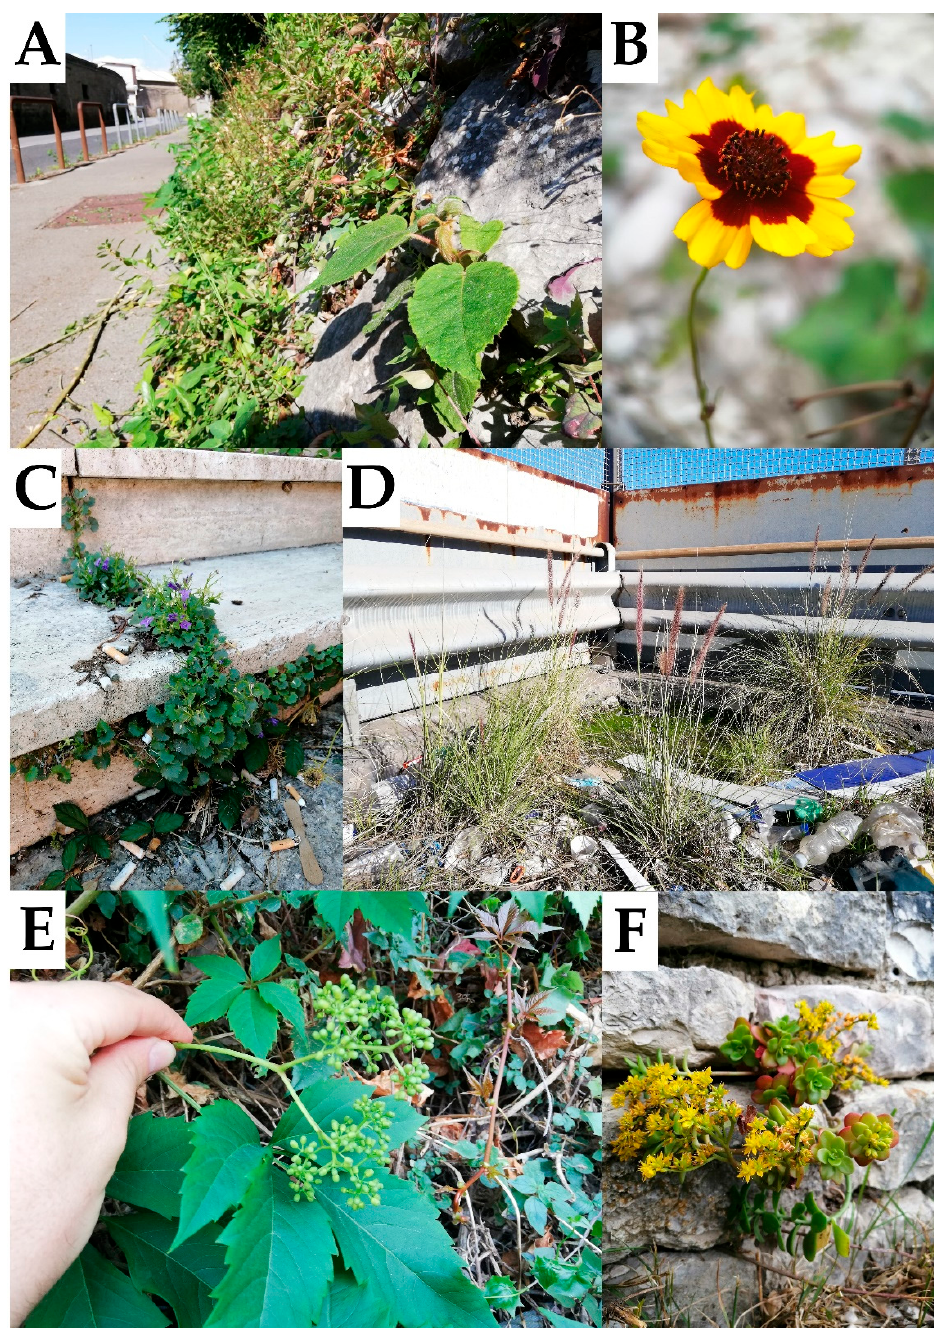
Figure 2. Some taxa reported as new for Italy and its regions. ( A ) Actinidia deliciosa (Campania, Castellammare di Stabia, 4 August 2019, photo: A. Stinca). ( B ) Bidens tinctoria (Marche, Cagli, 4 August 2021, photo: G. Mei). ( C ) Campanula portenschlagiana (Marche, Cagli, 30 August 2021, photo: G. Mei). ( D ) Cenchrus setaceus (Campania, Castellammare di Stabia, 1 January 2020, photo: A.